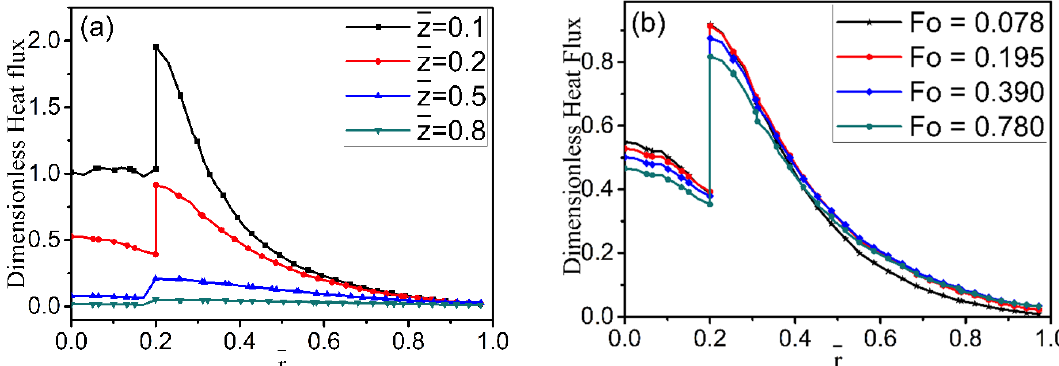
Figure 5. Effect of different distances on dimensionless heat flux without the nickel coating: ( a ) at Fo = 0.195; ( b ) at z(cid:3364) = 0.2.